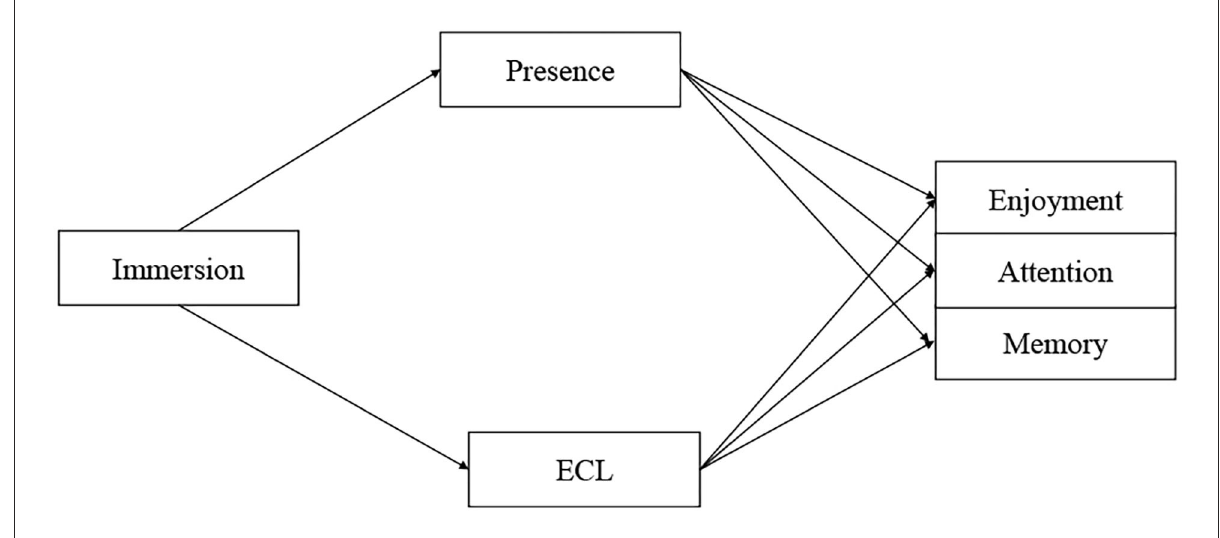
FIGURE1 Hypothetical model.